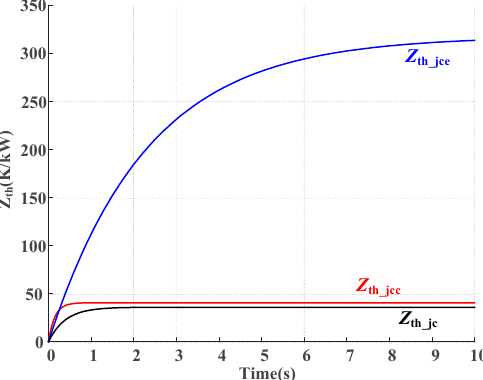
Figure 11. Thermal impedance curves between Z th_jcc , Z th_jce, and Z th_jc .